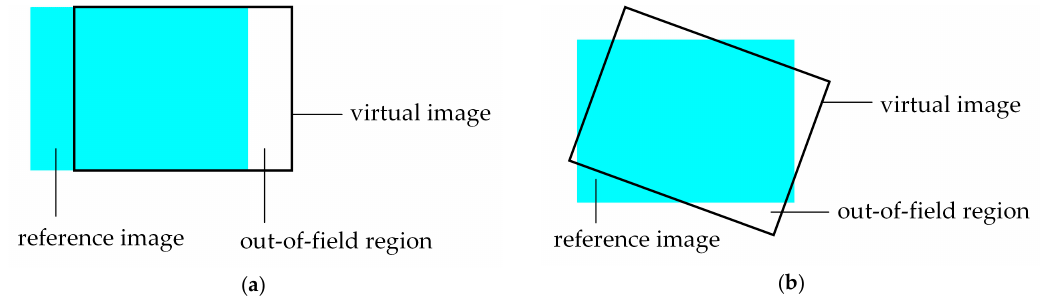
Figure 3. Positional relationship between reference view and virtual view: ( a ) Horizontal translation; and ( b ) Rotation and translation.